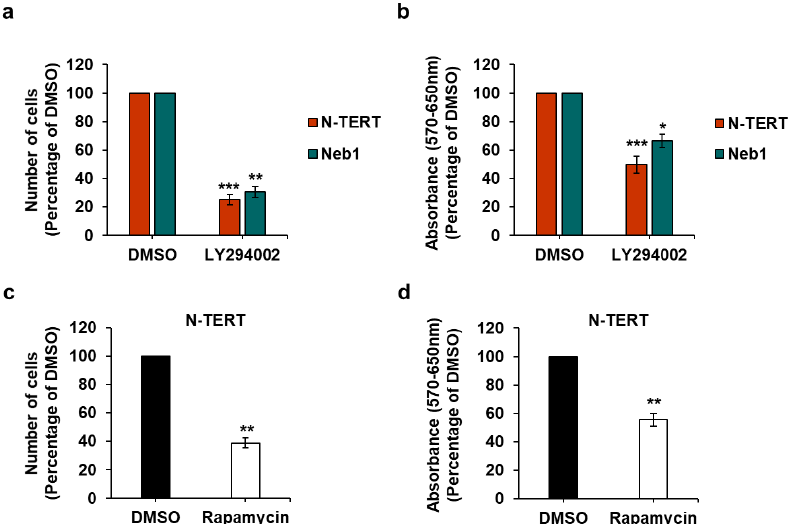
Figure 2. The PI3K/Akt/mTOR pathway regulates growth and viability of keratinocytes. ( a , b ) N-TERT and Neb1 cells were treated with 10 µM LY294002 or vehicle alone (DMSO) in complete medium supplemented with 10% fetal bovine serum (FBS). ( c , d ) N-TERT cells were treated with 10 nM rapamycin in complete medium supplemented with 10% FBS. After 72 h, number of cells was assessed by cell counting ( a , c ) and cell viability was assessed by MTT assays ( b , d ). Data are ex- pressed as percentage of results from cells treated with DMSO and are means ± SEM from n = 6 (( a , b ), N-TERT), n = 3 (( a , b ), Neb1), n = 3 ( c ) and n = 4 ( d ) independent experiments performed in duplicate ( a , c ) or triplicate ( b , d ). * p < 0.05, ** p < 0.01, *** p < 0.001 vs. DMSO.